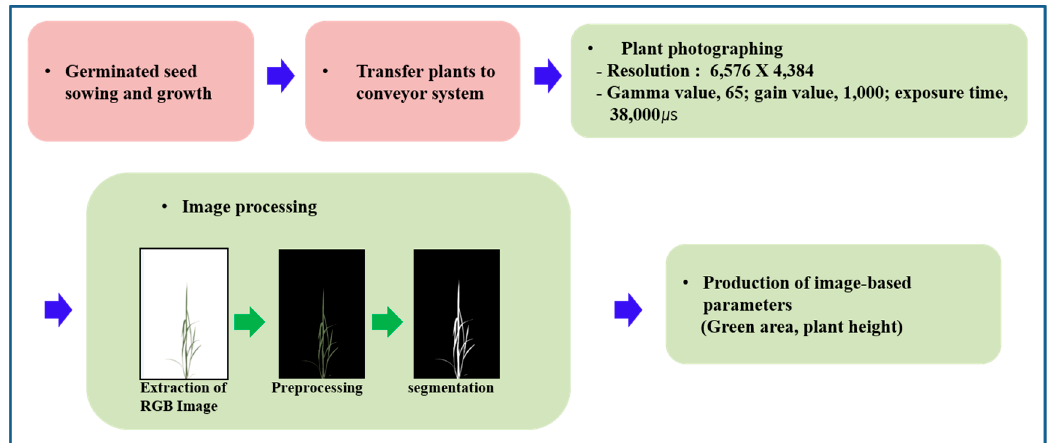
Figure 1. The process of image acquisition.